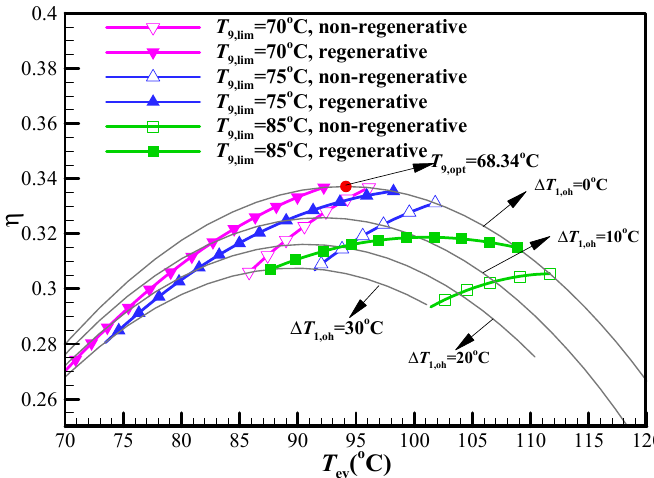
Figure 9. Plant exergy efficiency profiles with various reinjection temperature limits using isobutane.